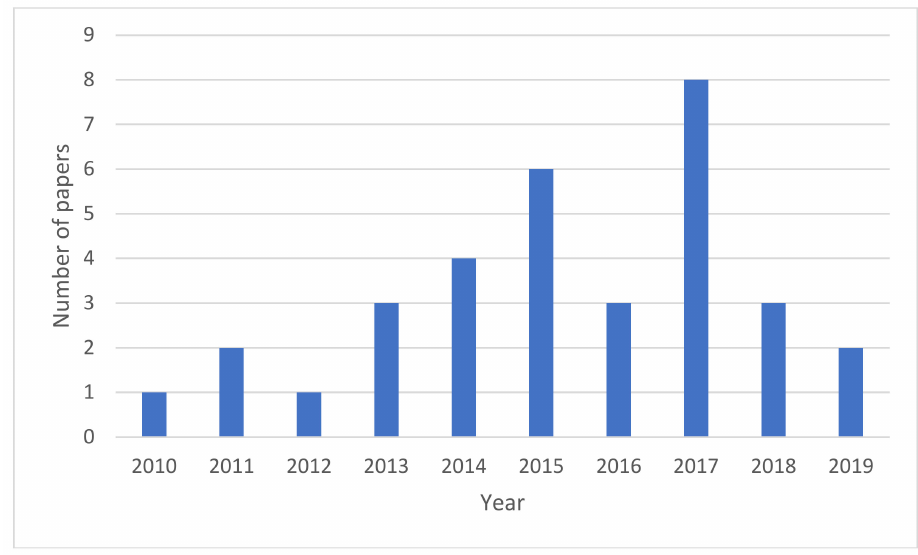
Figure 3. Distribution of selected papers by